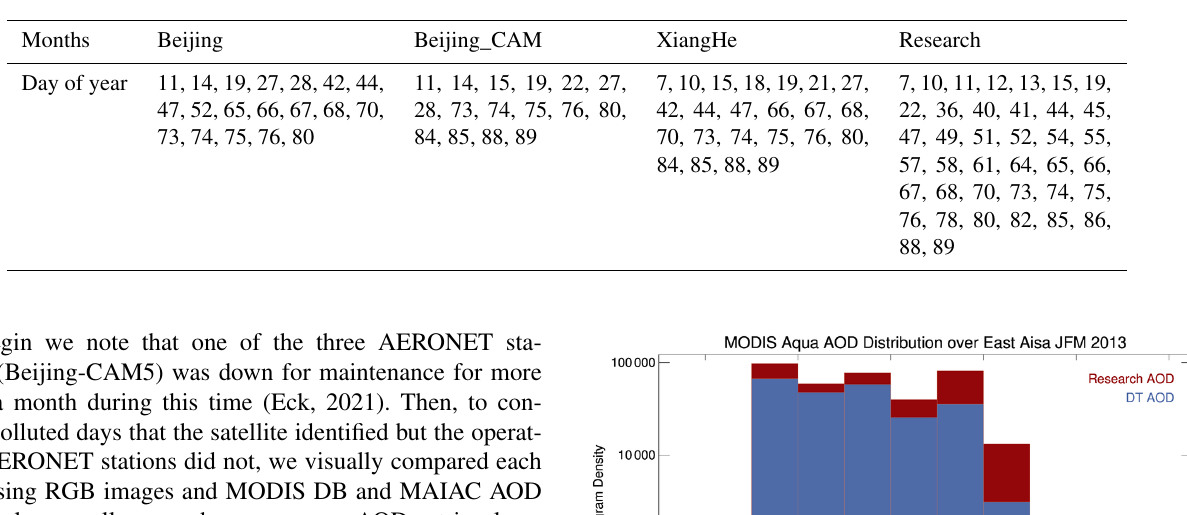
Table 3. Identified days with pollution events from January to March 2013 over the Beijing area (37–40 ◦ N and 115–118 ◦ E) using both AERONET and DT research products.